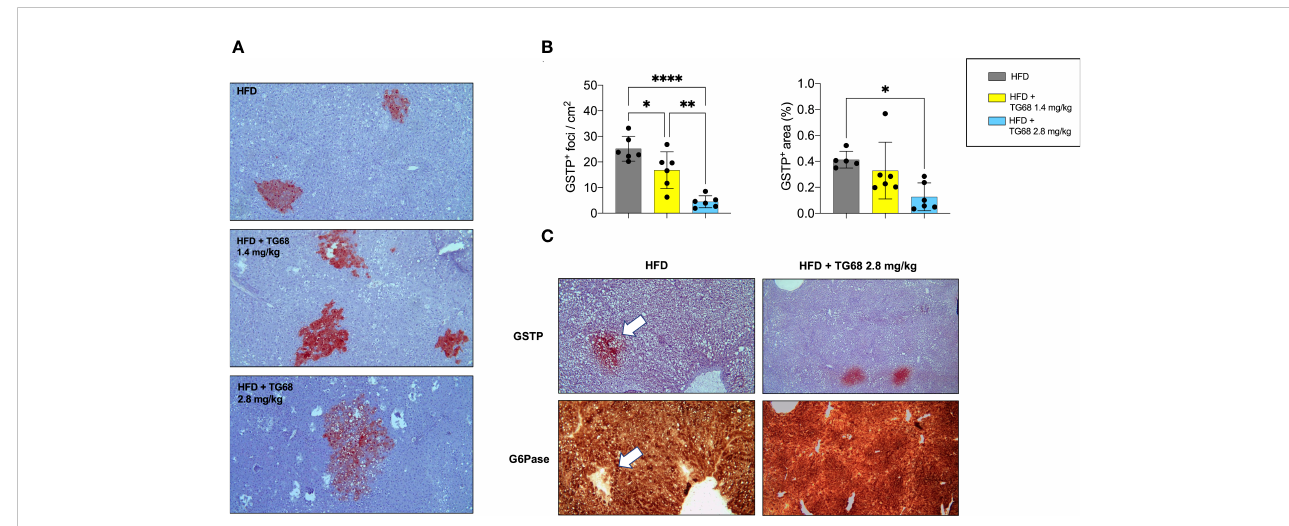
FIGURE 5 Reduction of fat accumulation does not always associate with regression of preneoplastic lesions. (A) Representative images of GSTP+ preneoplastic lesions from rats fed HFD alone or co-treated with 1.4 or 2.8 mg/kg of TG68 for the last 2 weeks (GSTP, 10x); (B) Number of GSTP+-foci per cm2 and percentage of liver occupied by GSTP+ lesions; (C) Representative image of serial liver sections. Arrows indicate that foci that are positive for GSTP are negative for G6Pase in rats fed HFD alone, but not in animals co-treated with TG68 (GSTP 10x; G6Pase 10x). The bar graphs represent mean values + SD of 5 to 6 rats/group. Groups were compared by using one-way ANOVA followed by Tukey post hoc analysis. *p<0.05, **p<0.01, ****p<0.0001. HFD, high fat